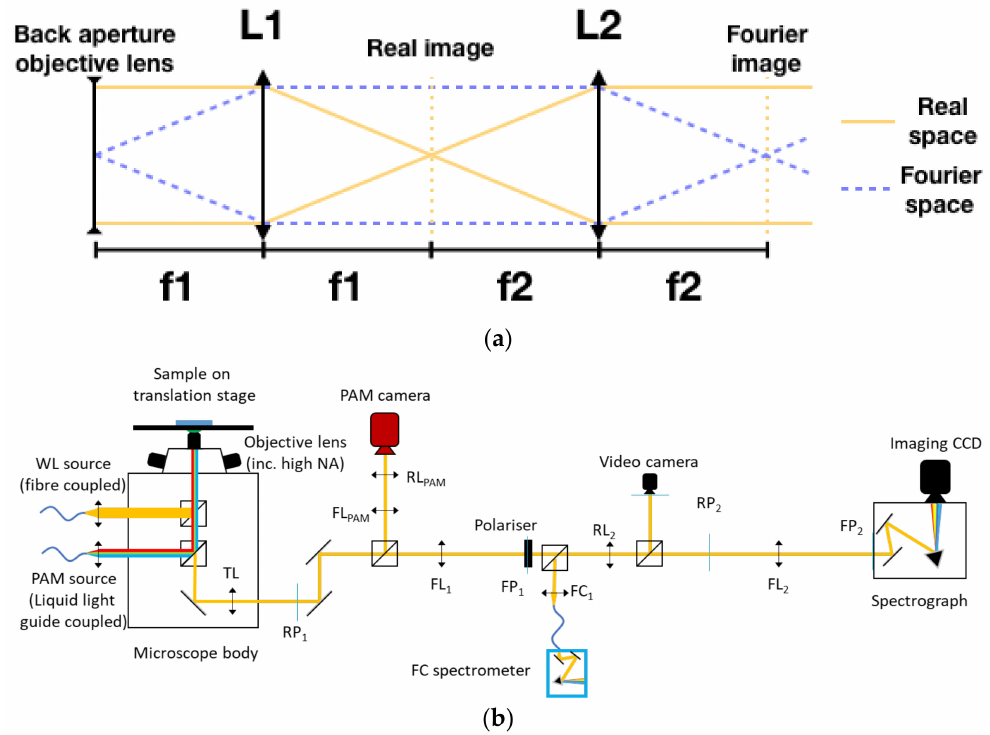
Figure 1. ( a ) The positioning scheme for lenses in a 4f Fourier system, with lines indicating the behaviour of both the real (imaging) and Fourier paths of light. Images are formed where the lines converge, gold for the real plane and dashed blue for the Fourier plane. This unit cell can be repeated, with the collimated beam beyond L2 being treated as that emerging from the objective lens. ( b ) Diagram of the optical system design, combining both the Fourier Image Spectroscopy and PAM detection paths. A series of the real plane (RL) and Fourier Plane (FL) lenses placed at their appropriate position, as determined by their focal lengths, guide the beam to image the Fourier plane/back aperture of the objective lens onto the spectrograph slit. The positions of the real (RP) and Fourier (FP) planes are also labelled. Distances between all lenses are the sum of their focal lengths, which can be adapted for each system based on the availability of space or resources. In this case, as the tube lens is from Nikon, f TL = 200 mm, and all other lenses are 200 mm to match, except FC 1, which is a 5 mm lens to illuminate the fibre